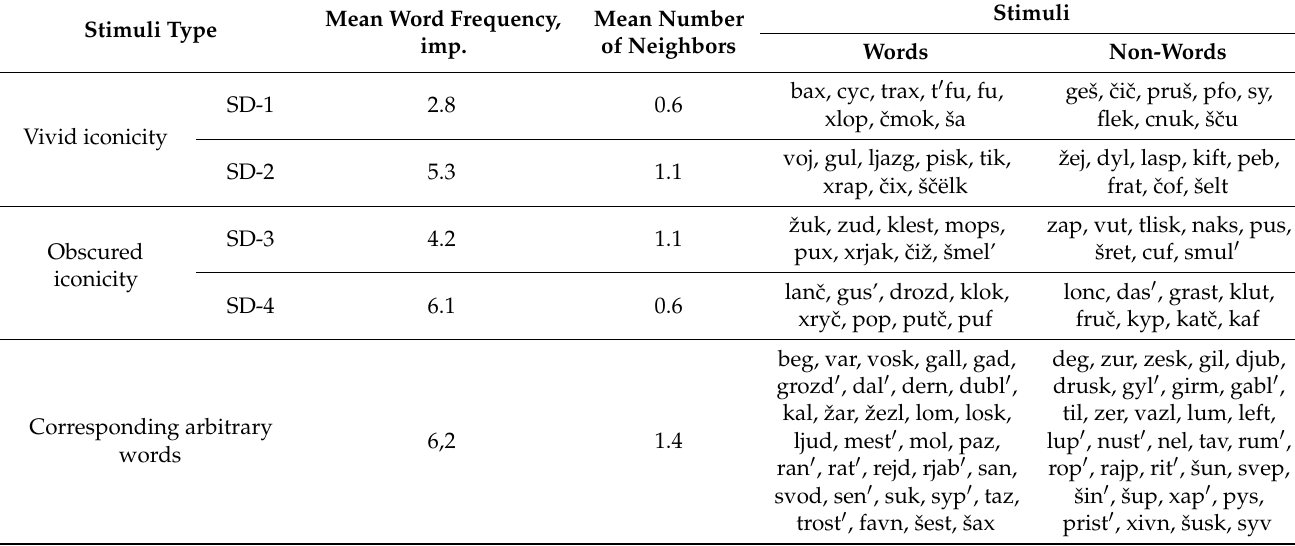
Table 2. Russian Experimental